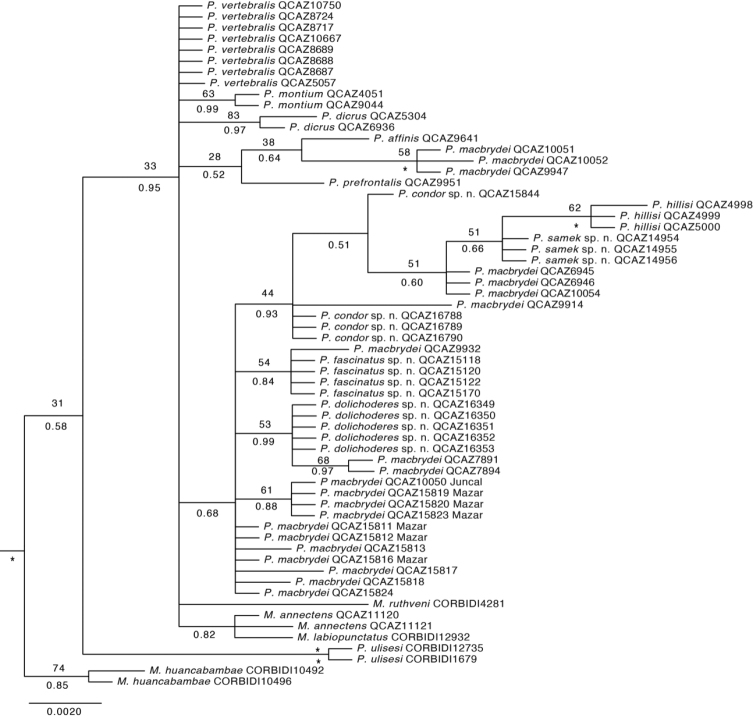
Phylogeny of Pholidobolus. ML phylogram derived from the analysis of 411 bp of nuclear DNA. Bootstrap values are shown above branches and Bayesian posterior probabilities below branches (≤ 50% not shown). Asterisks indicate maximum values. The outgroup taxon (Anadia
rhombifera) is not shown. Species names followed by voucher numbers are shown.